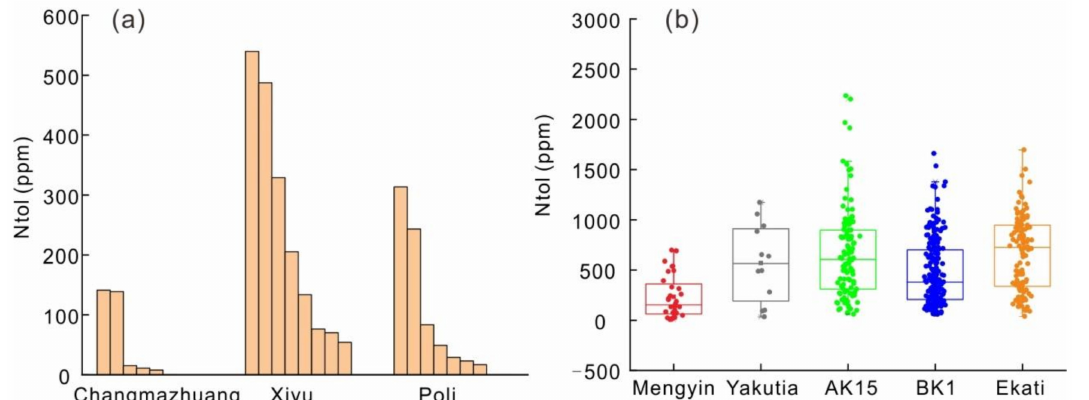
Figure 4. ( a ) Distribution diagram of N content in studied diamonds from the Poli, Xiyu and Chuangmazhuang belts; ( b ) Plot of N content of diamonds from different deposits worldwide: Mengyin deposit from Shandong province, China; Yakutia deposit from Russia; AK15 and BK1 mines from Orapa cluster, Botswana; Ekati deposit from Northwest Territories, Canada